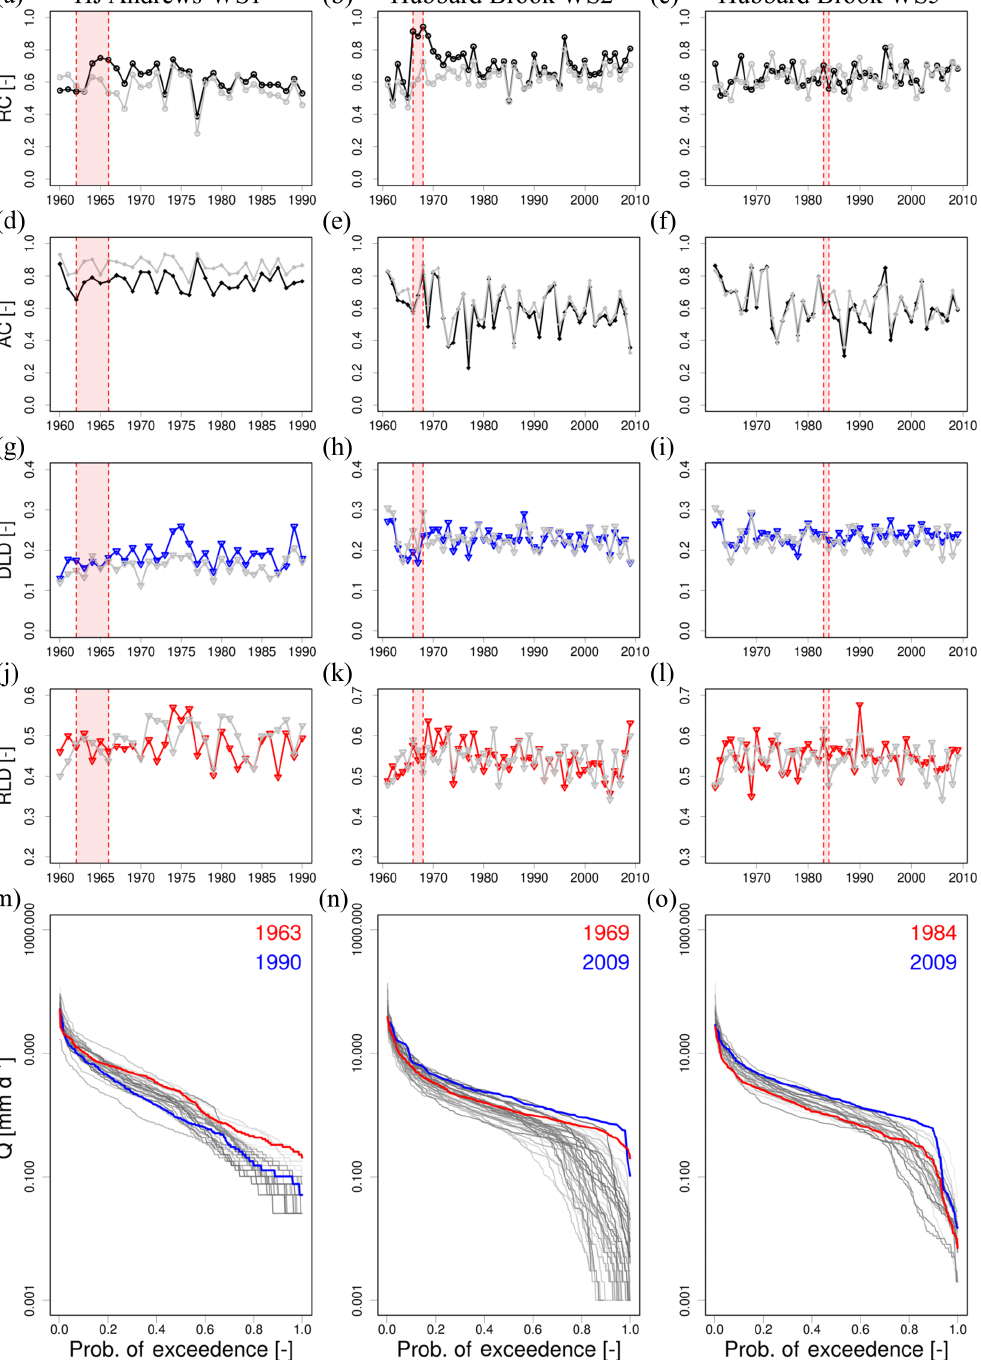
Figure 2. Evolution of signatures in time of ( a – c ) the runoff coefficient, ( d – f ) the 1-day autocorrelation, ( g – i ) the declining limb density, ( j – l ) the rising limb density with the reference watersheds in grey and periods of deforestation in red shading. The flow duration curves for HJ Andrews WS1, Hubbard Brook WS2 and Hubbard Brook WS5 are shown in (m) – (o) , where years between the first and last year are coloured from light gray to dark grey as they progress in